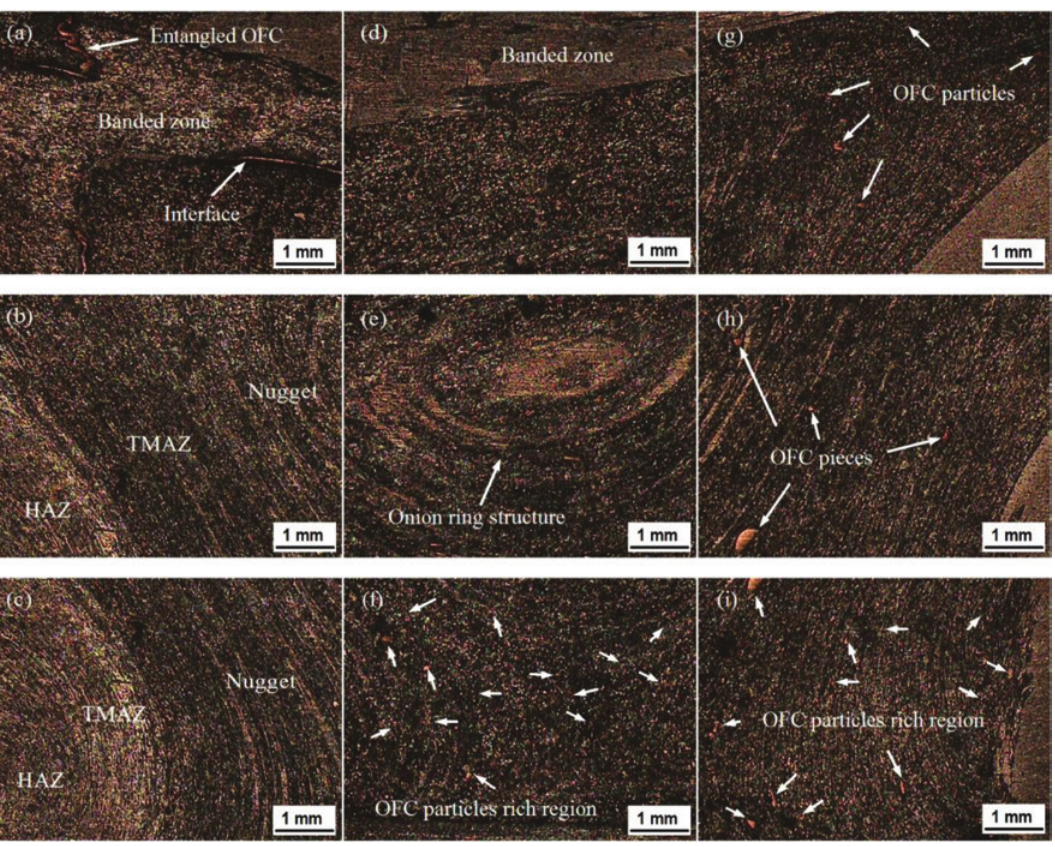
Figure 4: Optical microscope images taken from the cross section of different areas in dissimilar metal butt joints at a rotation speed of 2896 rpm. (a) to (i) Indicates sampling locations as shown in Figure